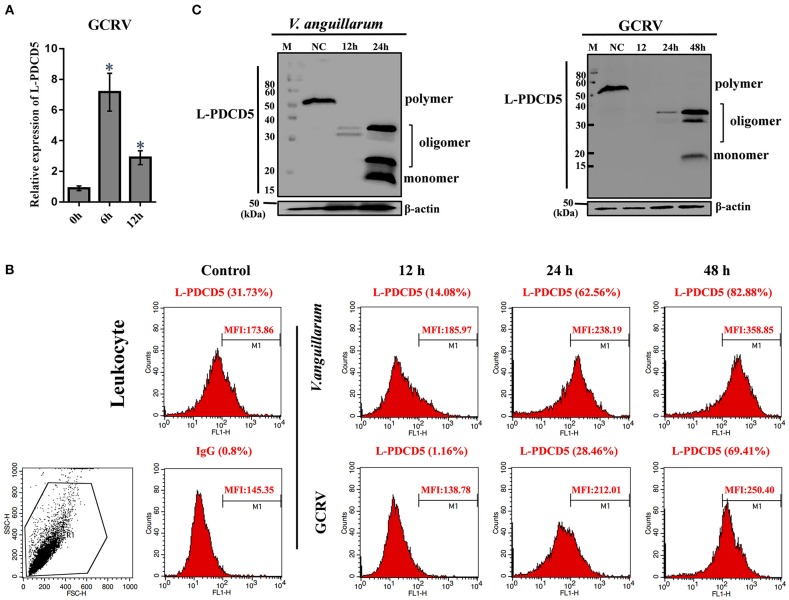
The functions of L-PDCD5 in the immune responses of lampreys. (A) Q-PCR analysis of the expression patterns of L-PDCD5 in leukocytes at 0, 6, and 12 h after lampreys were challenged with GCRV. All of the data are presented as the means ± SDs based on three independent cDNA samples with three replicates per sample. The asterisks indicate significant differences (n = 3 and *P < 0.05) compared to the control. (B) Immunofluorescence analysis of PDCD5 surface expression in leukocytes at 0, 12, 24, and 48 h after lampreys were challenged with or without V. anguillarum and GCRV treatment were bound to the rabbit anti-rL-PDCD5 antibody and incubated with FITC-conjugated anti-rabbit IgG secondary antibodies followed by FACS analysis. Numbers above bracketed lines indicate percent PDCD5 positive cells mean fluorescence intensity. Percentages indicate the number of PDCD5 positive cells. (C) Western blotting analysis of the L-PDCD5 expression in leukocytes at different periods after the challenges with V. anguillarum and GCRV infection using the rabbit anti-rL-PDCD5 antibody. β-actin was used as a loading control. All experiments were repeated at least three times with similar results.